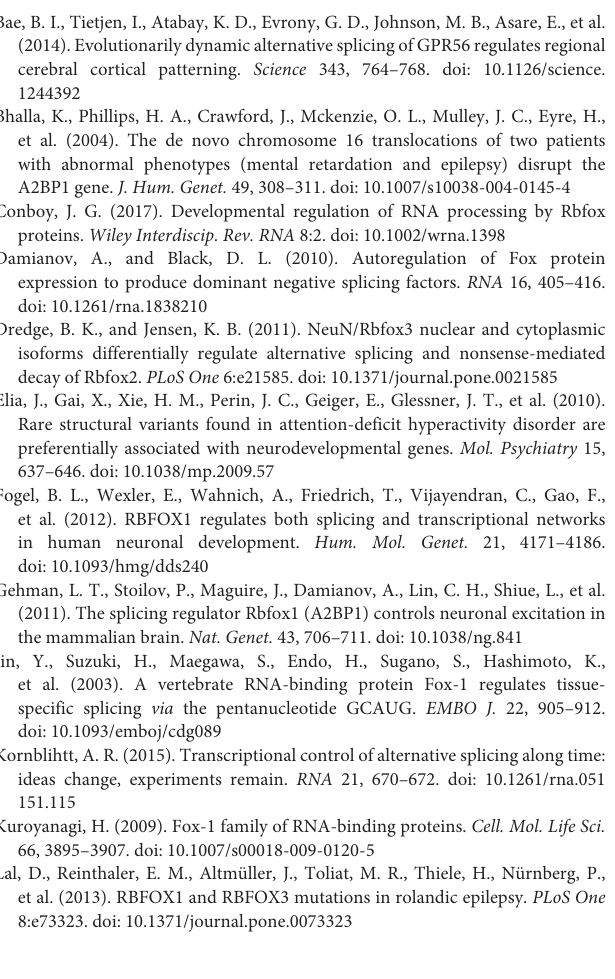
are shown. At the top of each page is a schematic of the known Rbfox1 exons (18). RRM, RNA recognition motif; NLS, nuclear localization signal; pA, polyadenylation site; ATG, translational start codon. FIGURE S2 | Expression of the alternative 3 (cid:48) end of the Rbfox1 gene during cortex development. Total RNA was isolated from the cerebral cortex of different embryonic and perinatal stages and subjected to RT-qPCR with primers corresponding to Rbfox1 exons 20/21 or the alternative 3 (cid:48) end ( n = 3); mRNA expression was normalized to Gapdh. FIGURE S3 | Rbfox1 first exon 1B is expressed in the cortical plate of the mouse embryo. (A) In situ hybridization of Rbfox1 (genepaint.org) showing Rbfox1 expression in the cortical plate, and several other brain regions. (B,C) In situ hybridization carried out with probes corresponding to total Rbfox1 (B) or Rbfox1 1B (C) . A high expression level of Rbfox1 1B was detected in the cortical plate. FIGURE S4 | Expression of the Rbfox1 alternative first exons in different subregions of the juvenile brain. RT-qPCR with primers corresponding to Rbfox1 exons 20/21 or the alternative first exons. Total RNA was isolated from different brain subregions of 6-weeks old mice, and cDNA synthesis and qPCR were performed; mRNA expression was normalized to